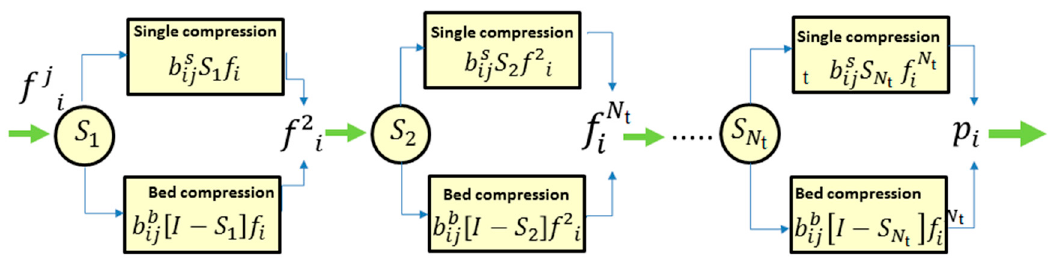
Figure 4. Block scheme of the reformed Austin model [6,19] for several steps of comminution in high pressure roll crusher. f ij represents the feed for each sub-process, with i = 1 . . . n , and n is the particle size distribution (PSD) vector length: Furthermore, j = 1 . . . N t , and N t is the number of stages of the whole process. S i is the selection function for each sub-process, with i = 1 . . . N t . Finally, p i is the final product of the high-pressure roll crusher.